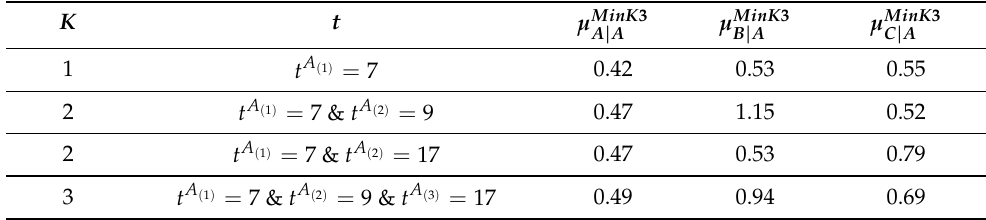
Table 2. The µ MinK 3 indices for three time series A , B and C